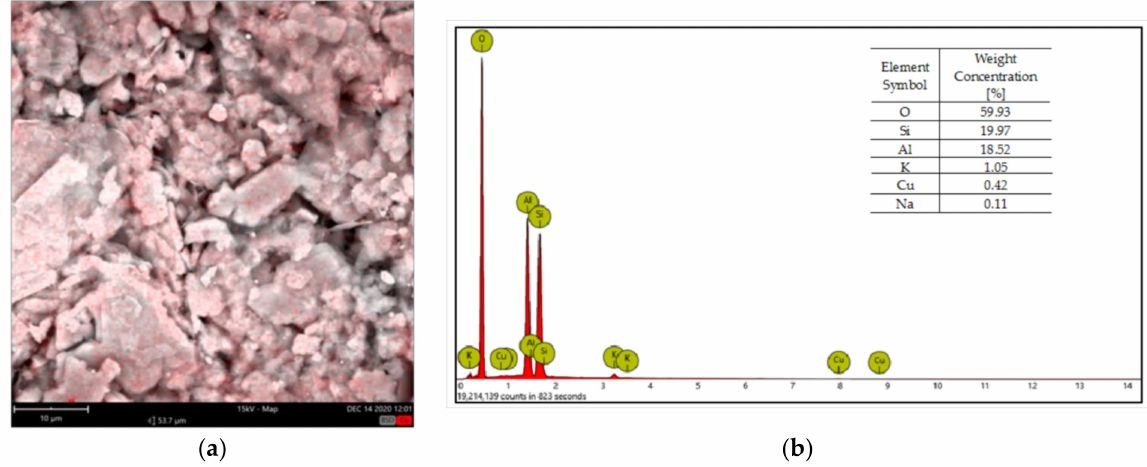
Figure 2. SEM-EDS maps ( a ) and elemental composition ( b ) of kaolinite after the Cu(II) adsorption (copper is marked in red).